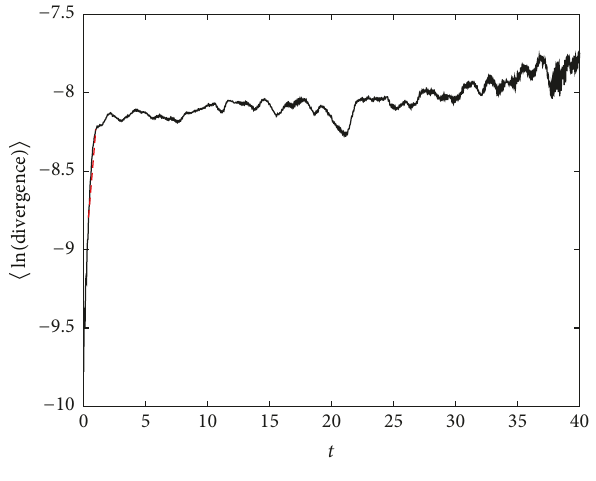
Figure 16: The largest Lyapunov exponents.